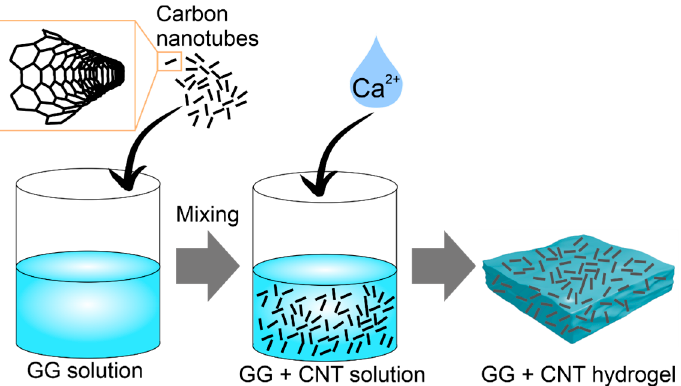
Figure 1. Schematic of the synthesis of gellan gum (GG)-carbon nanotubes (CNTs) hydrogel hybrid surfaces. The added carbon nanotubes are depicted as dark rods, while the GG solution is light blue at the beginning ( left ) but turns into harder hydrogel ( right ).